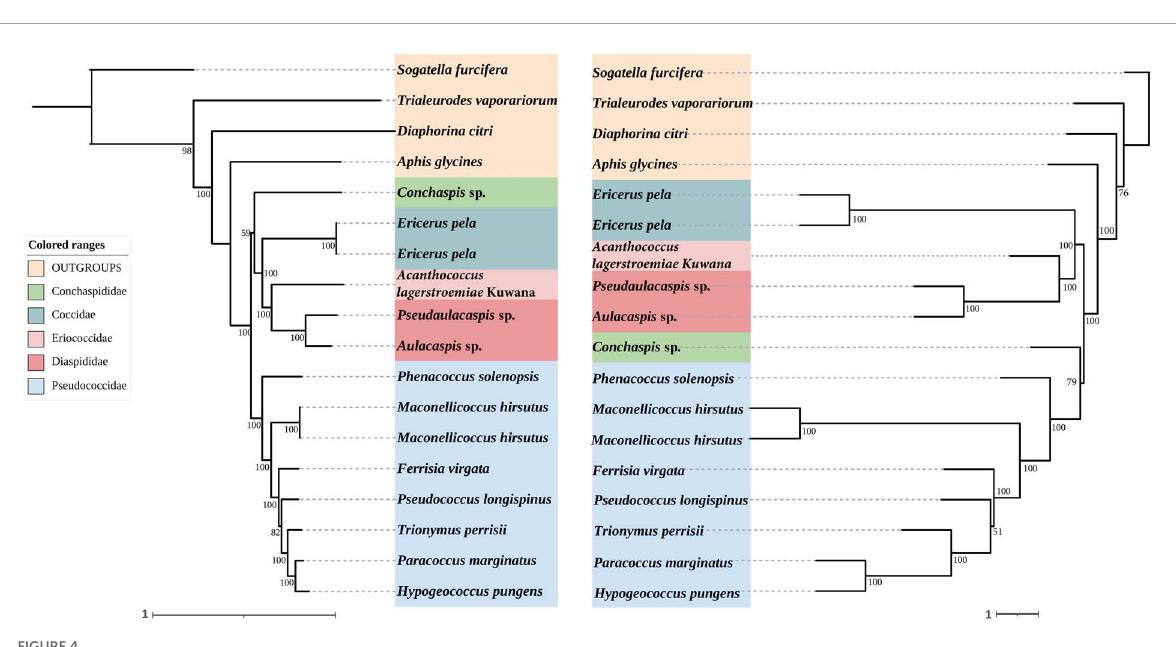
The placement of Conchaspididae in the tree was